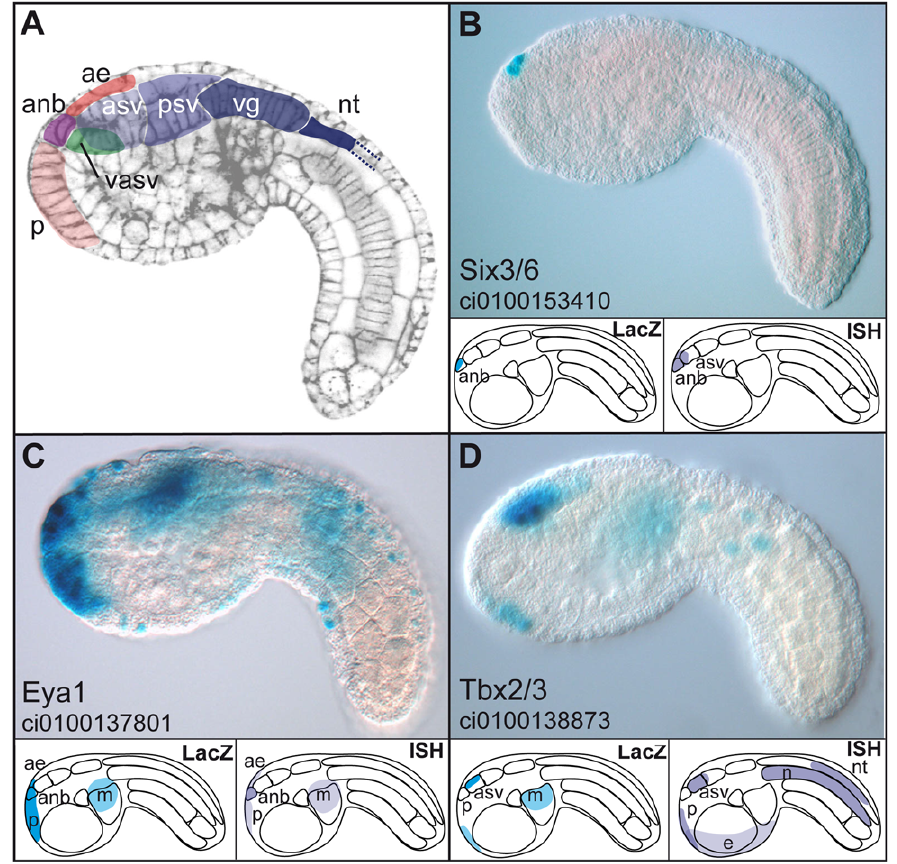
Figure 5. Enhancers with duplicated GATTA are active in the anterior region of the ascidian embryo. (A) Schematic representation of the main regions of gene expression in a mid-tailbud Ciona intestinalis embryo. Cell cortices are stained with Alexa-phalloidin (Christiaen et al. 2007). (B–D): expression domains of three enhancers, respectively from Ci-Six3/6 , Ci-Eya1 and Ci-Tbx3 after electroporation and X-Gal staining at mid-tailbud stage. Lower panels show a schematic representation of the LacZ expression driven by the enhancer (left) and endogenous gene expression as assayed by in situ hybridization (ISH) (right). Enhancers can be subdivided into different classes following their expression domains: very restricted expression only in the ANB while the gene expression domain is slightly larger (Six3, (B)); broad anterior expression recapitulating more or less the endogenous expression pattern (Eya, (C)); only the most anterior expression domains are driven by the enhancer (Tbx3 (D)). anb: anterior neural boundary, asv: anterior sensory vesicle, psv: posterior sensory vesicle, vg: visceral ganglion, nt: neural tube, ae: anterior epidermis (or